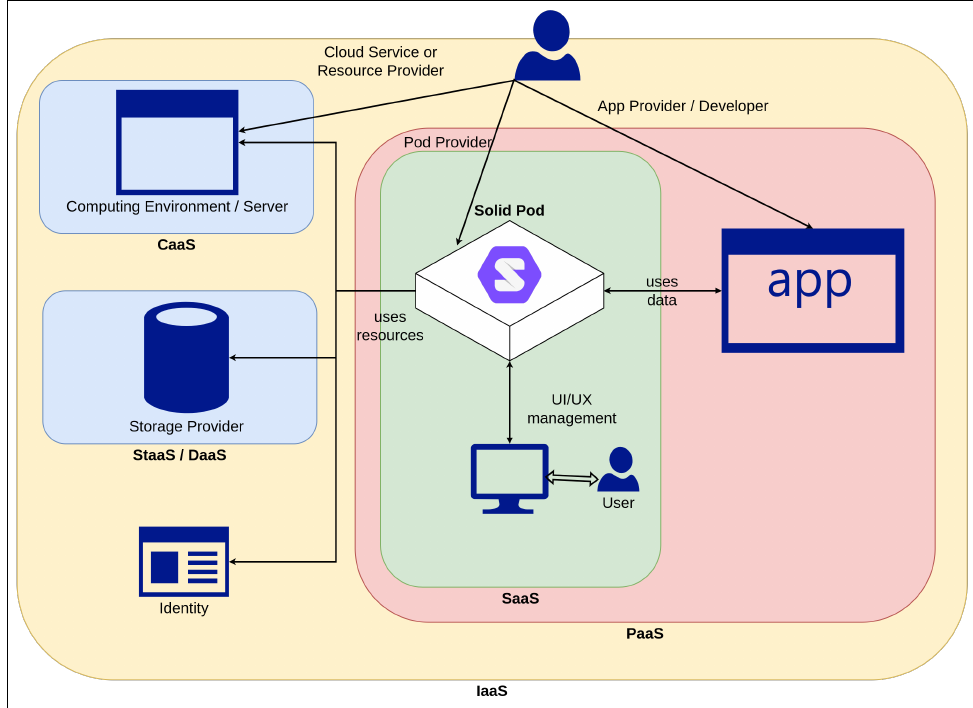
Figure 1. Simplified representation of applying Cloud paradigms to provisioning Solid